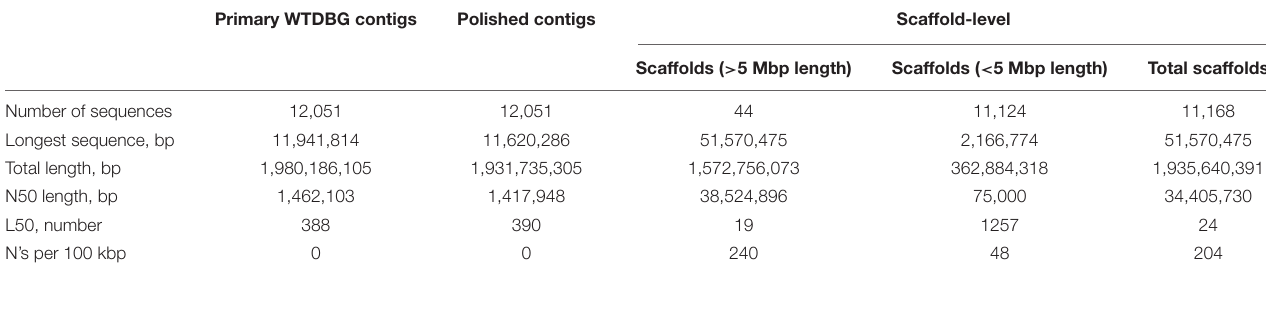
TABLE 1 | Summary statistics for assembled genome of P. indicus